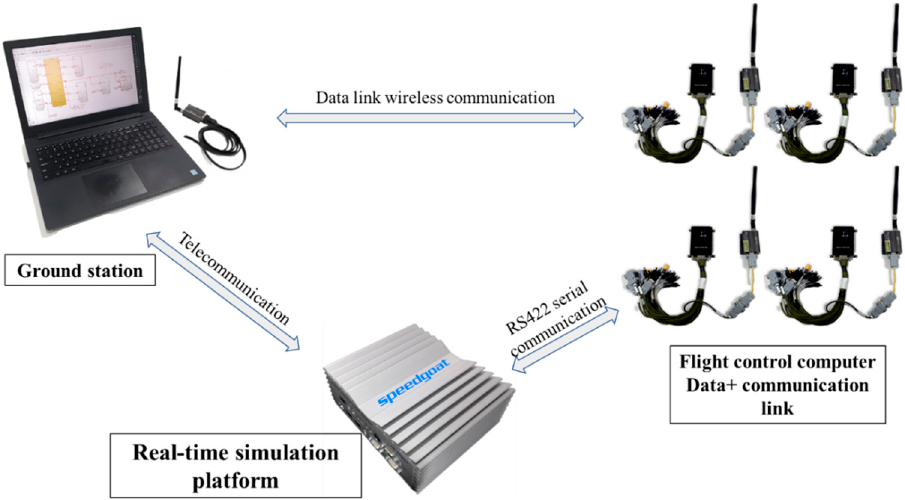
Figure 14. Device connection diagram for hardware-in-the-loop simulation.